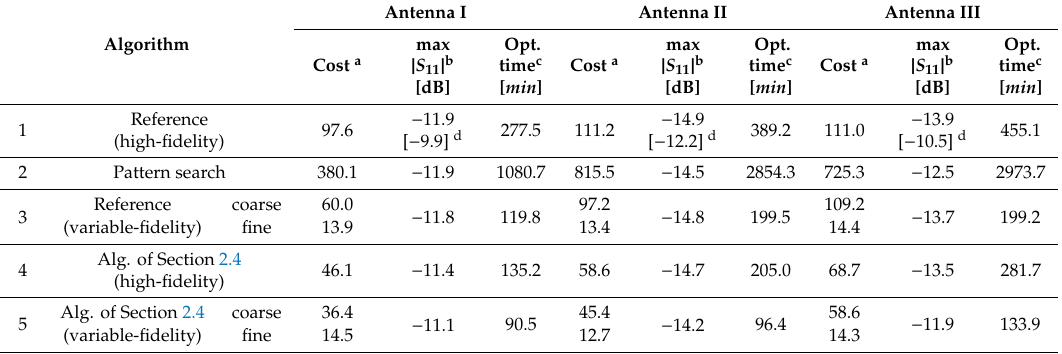
Table 3. Performance statistics of the proposed algorithm in the variable-fidelity